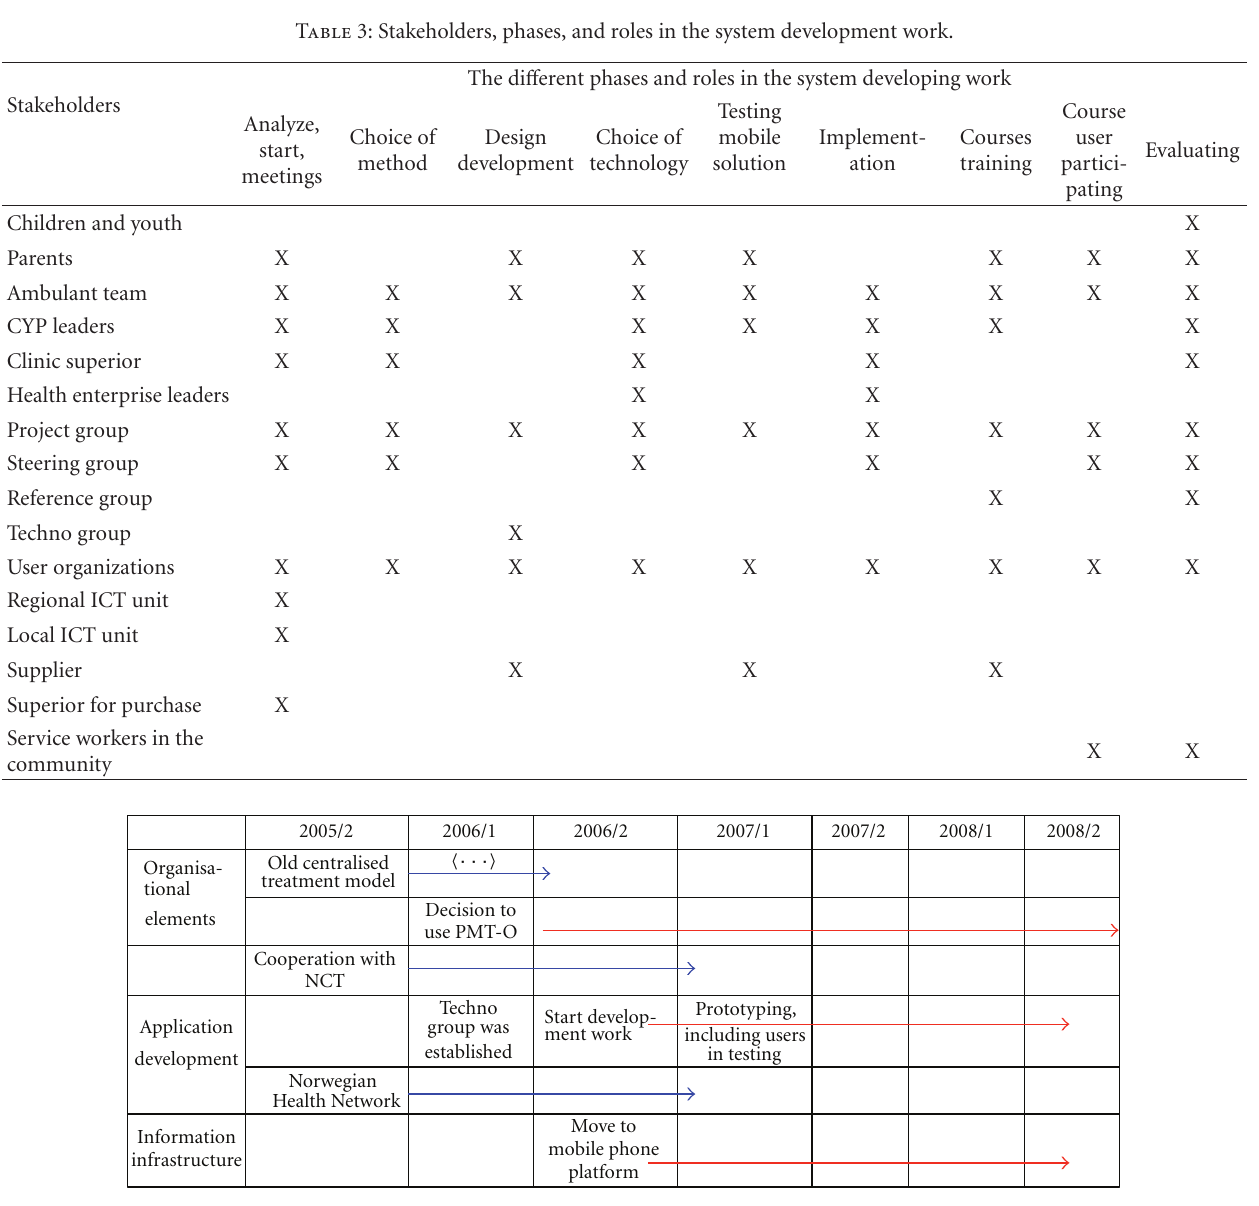
Figure 4: Project